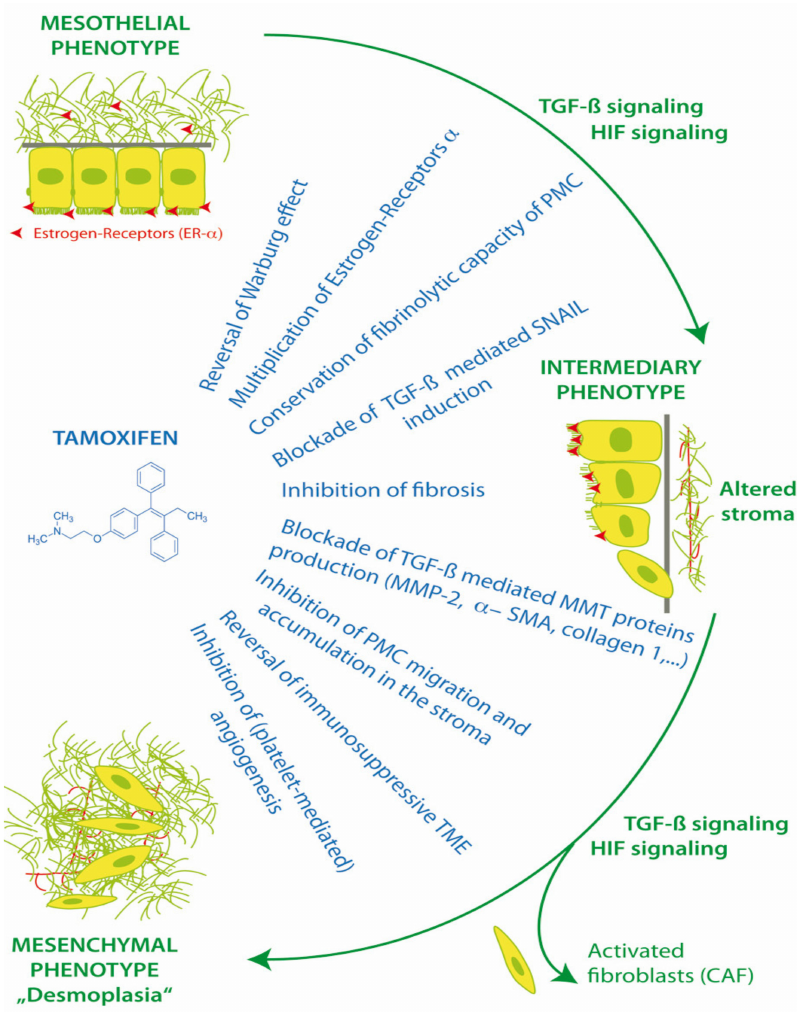
Figure 3. Action of tamoxifen in treatment of mesothelial to mesenchymal